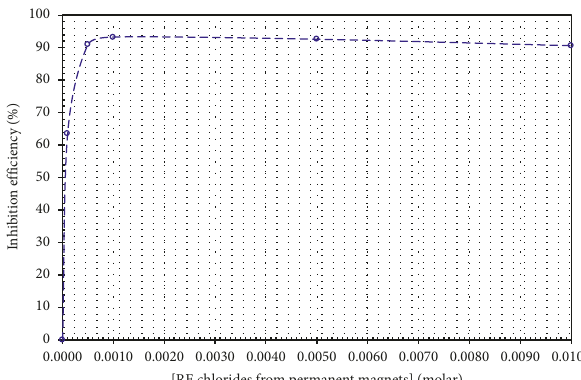
Figure 11: Effect of inhibitor concentration, synthesized from permanent magnets, on the corrosion inhibition efficiency of API X70 steel in 3.5% NaCl solution at room temperature.